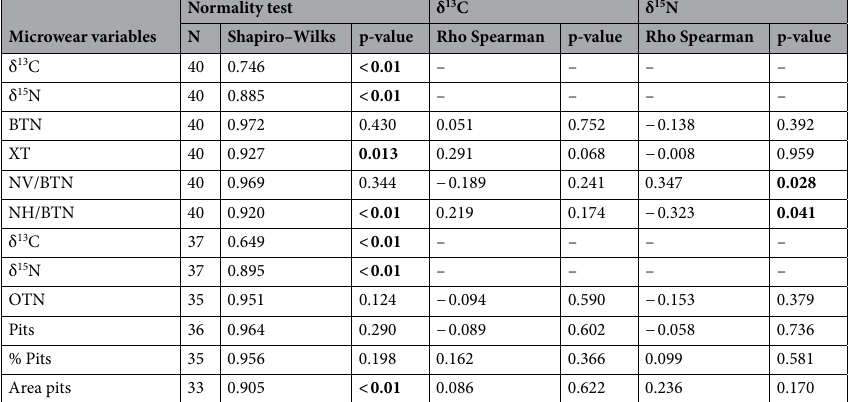
Table 3. Normality test and Spearman correlations between microwear variables and isotope ratios. N total number of samples included, BTN number of striations on the buccal surface, XT length of striations, NV/ BTN vertical index, NH/BTN horizontal index, OTN total number of striations in the occlusal surface, %Pits percentage of pits. Significant correlations (p < 0.05) in